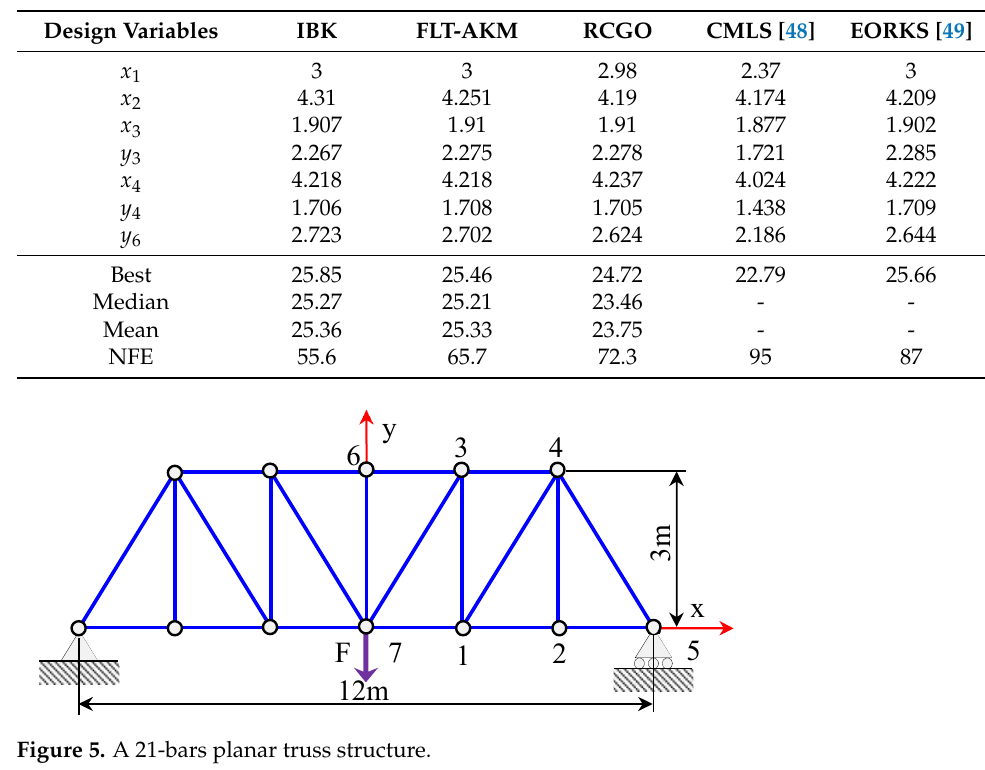
Table 3. Comparison of the obtained results for the 21-bars planar truss. Design Variables